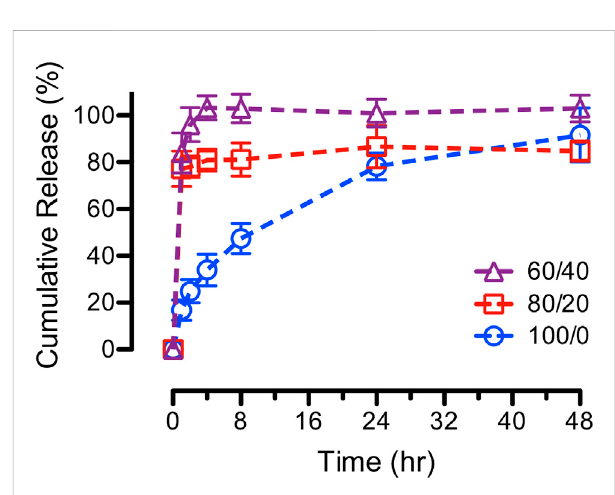
FIGURE 11 In-vitro cumulative release curves of ASA from various blends of PCL/CS fi bers on the effects of modifying PCL concentrations (e.g., 100/0 = 15%/4% PCL/CS, 80/20 = 17.75%/4% PCL/CS, and 60/40 = 22.33%/4%